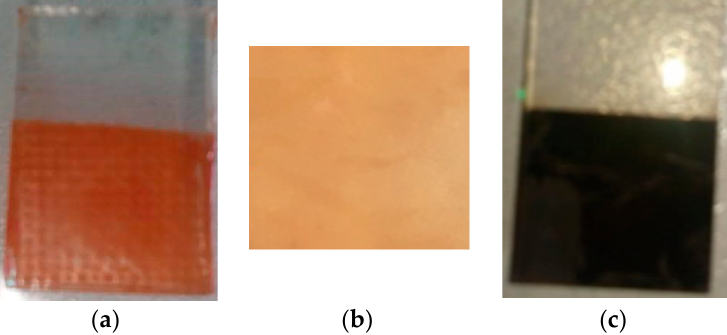
Figure 7. Fe 2 O 3 -based photoanode ( a ), solid polymeric membrane ( b ) and CuO-based photocathode ( c ).